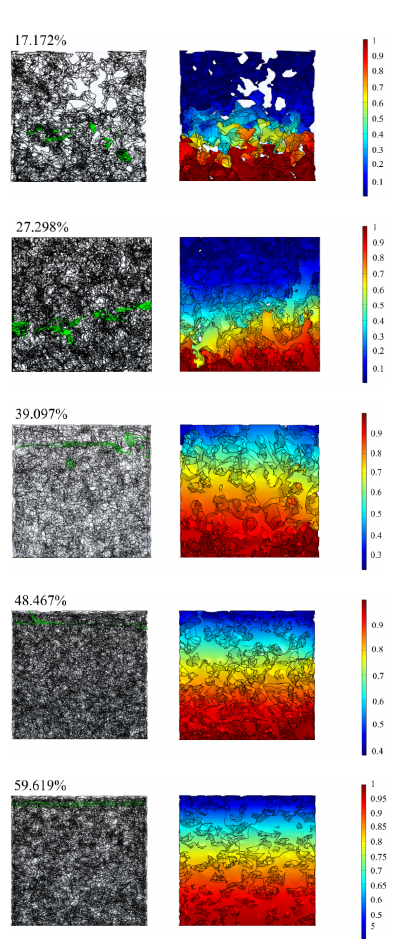
Figure 20. Oil level ( left ) and oil volume fraction ( right ).